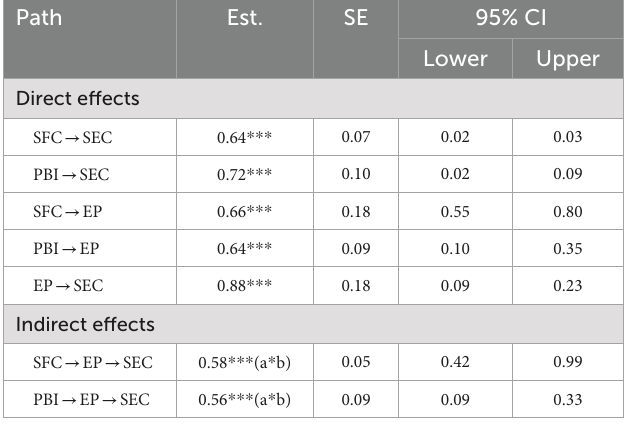
TABLE 2 Standardized estimates for direct and indirect effects of variables.